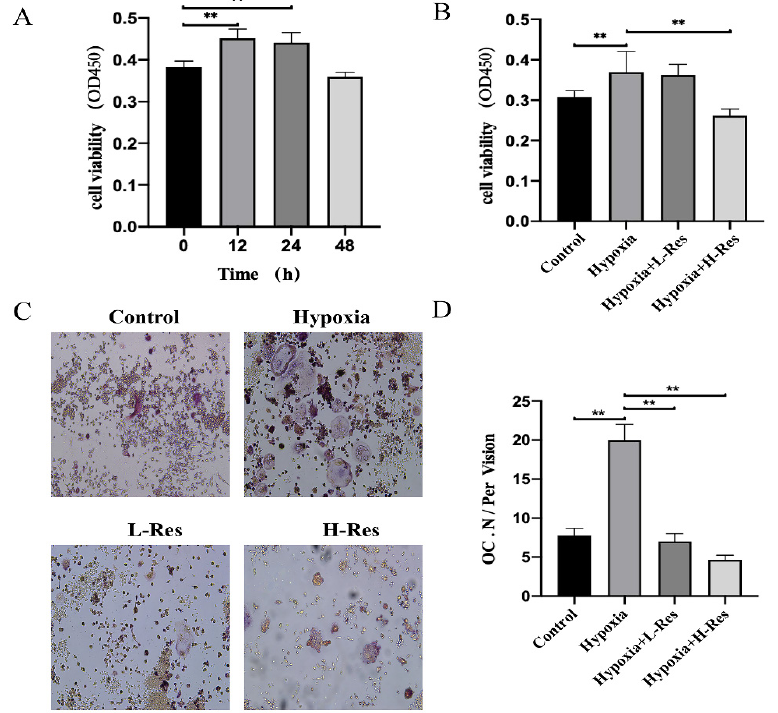
Figure 2. RES inhibited the cell viability and osteoclastogenesis in RAW264.7 under hypoxia. ( A ) The viability of RAW264.7 under hypoxia was measured. ( B ) The viability of RAW264.7 from control group, hypoxia group, L-RES group and H-RES group was detected. ( C ) TRAP staining results of RAW264.7 from control group, hypoxia group, L-RES group and H-RES group and ( D ) quantification. Values were expressed as mean ± SD. ** p < 0.01; all the assays were repeated more than three times.